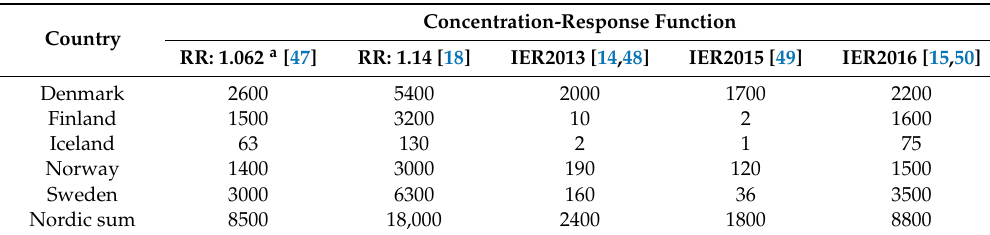
Figure 3. Deaths attributable to PM 2.5 mean exposure estimated with di ff erent concentration- Figure 3. with different response functions. concentration-response functions. Table 7. Deaths attributable to mean PM 2.5 exposure in Nordic countries evaluated using di ff erent C-R